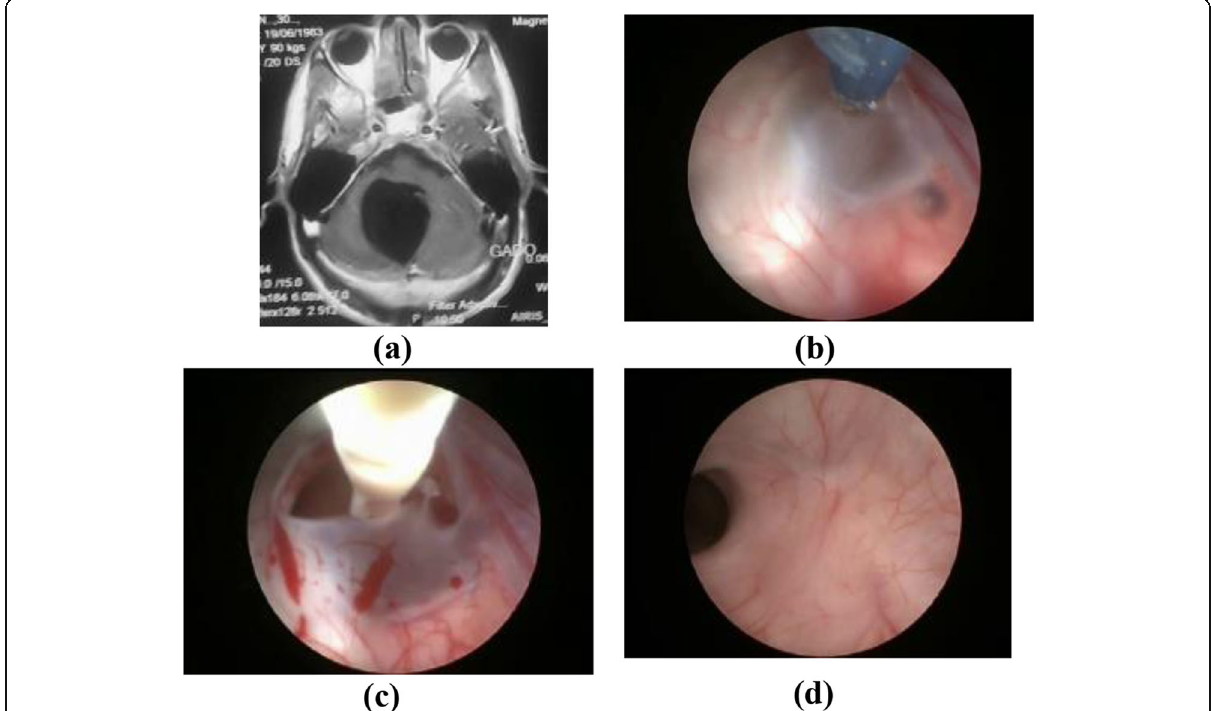
Fig. 7 a MRI T1 axial sequence with contrast showing posterior fossa cyst related to the fourth ventricle and compressing it. b Endoscopic view showing identification of the fourth ventricular wall from inside the cyst and performing endoscopic cystoventriculostomy. c Applying a fenestration between the cyst and the ventricle with a Fogarty catheter. d Endoscopic navigation inside the fourth ventricle with identification of the aqueduct of